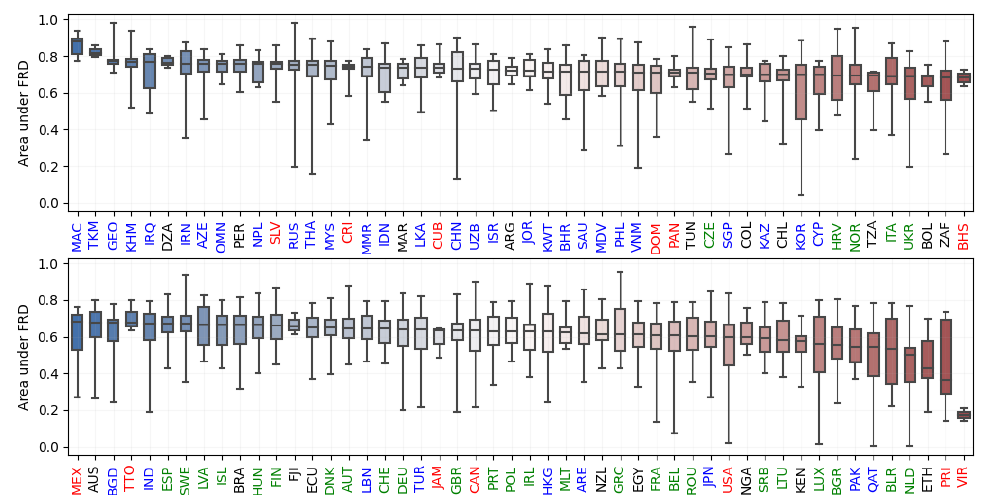
Figure 6. Deviation of the area under FRD for all countries in this study.